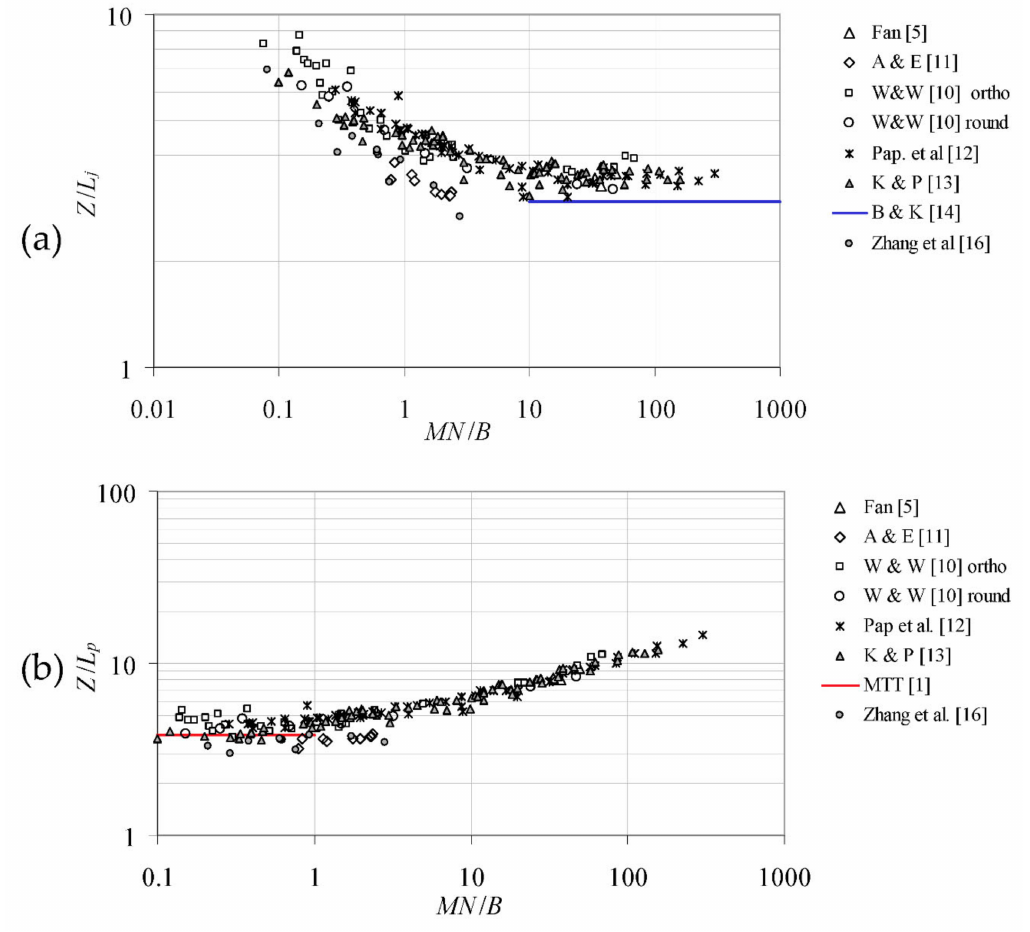
Figure 1. Normalized terminal rise height ( a ) Z / L j and ( b ) Z / L p versus the dimensionless parameter MN / B from earlier